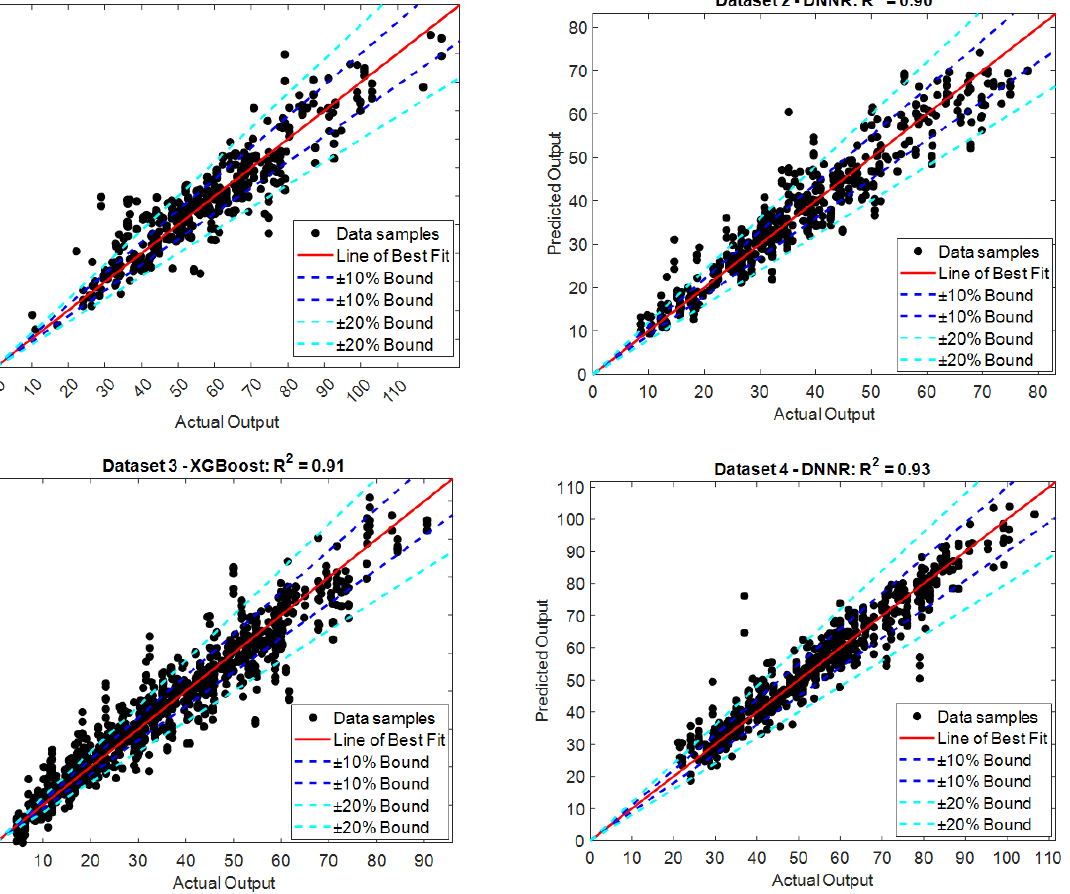
Figure 6. The correlation between the actual and predicted CS. Table 7. Model configuration of the DNNR models that helps to attain the best